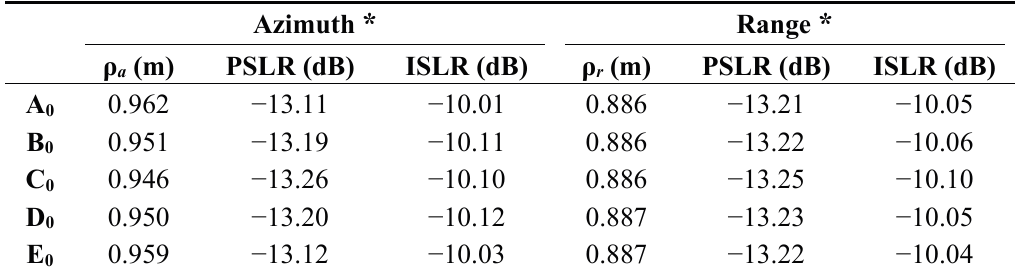
Figure 9. Contour plots and range/azimuth slices for target A0. ( a ) Imaging results of the traditional algorithm; ( b ) Imaging results of our proposed algorithm. Table 3. Imaging quality analysis for the five point targets.